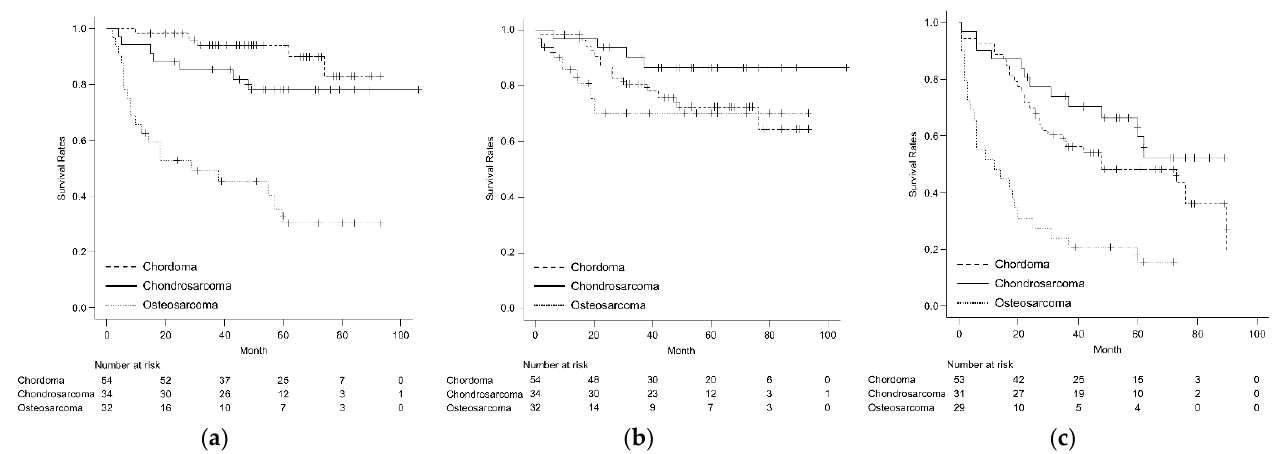
Figure 2. ( a ) The comparison of overall survival among the patients with chordoma, chondrosarcoma, and osteosarcoma; ( b ) the comparison of local control rates among the patients with chordoma, chondrosarcoma, and osteosarcoma; ( c ) the comparison of progression-free survival among the patients with chordoma, chondrosarcoma, and osteosarcoma. Table 5. Univariate and multivariate analyses for PFS in M0 patients.